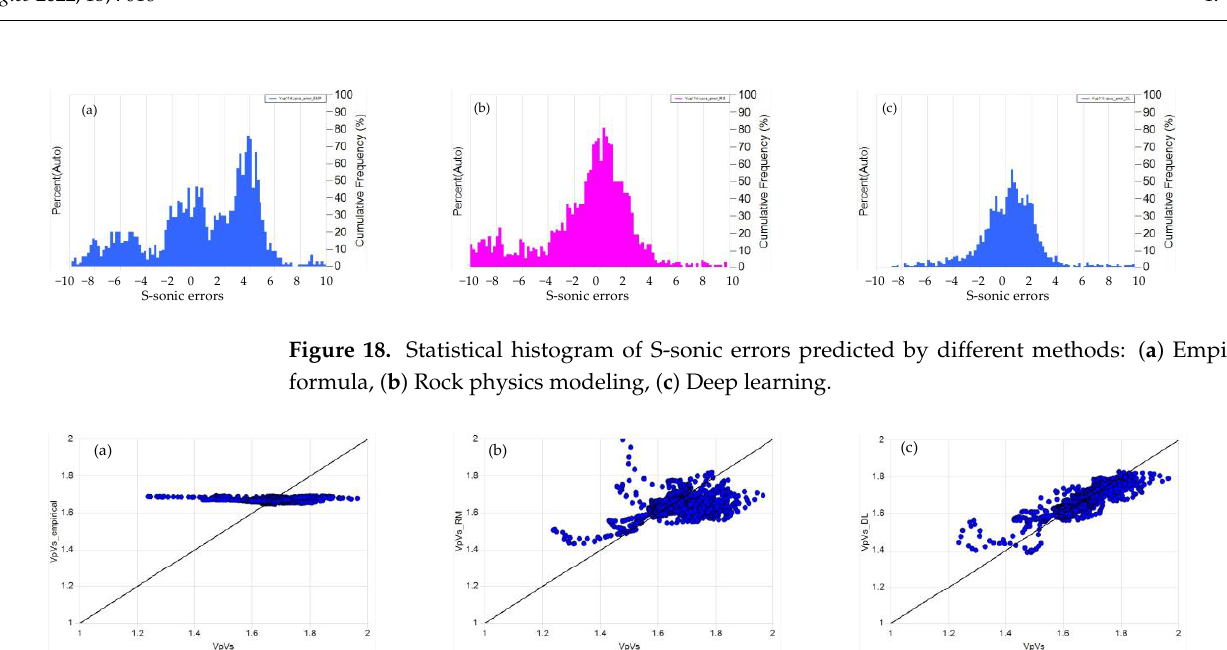
Figure 19. Crossplot of Vp/Vs predicted by different methods ((a) Empirical formula, (b) Rock physics modeling, (c) Deep learning) and measured Vp/Vs in well validation.